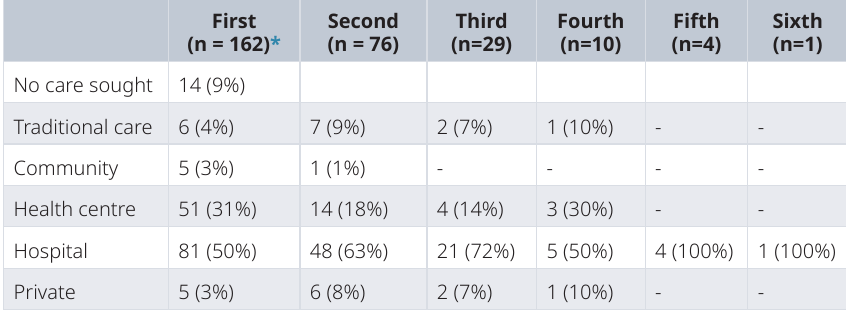
Table 3. Description of location of